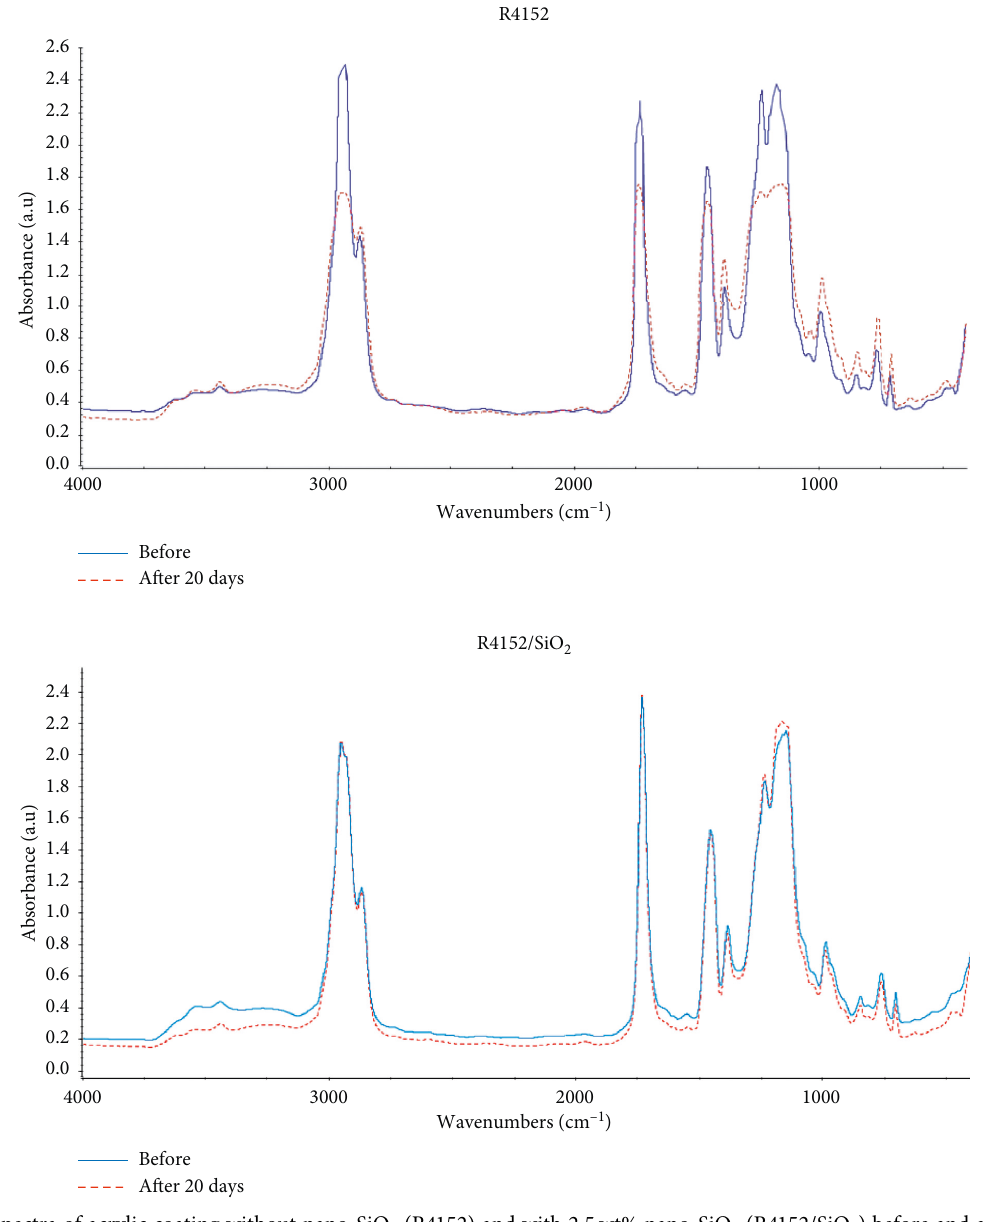
Figure 2: IR spectra of acrylic coating without nano-SiO 2 (R4152) and with 2.5 wt% nano-SiO 2 (R4152/SiO 2 ) before and after 20 days of exposure in the saturated Ca(OH) 2